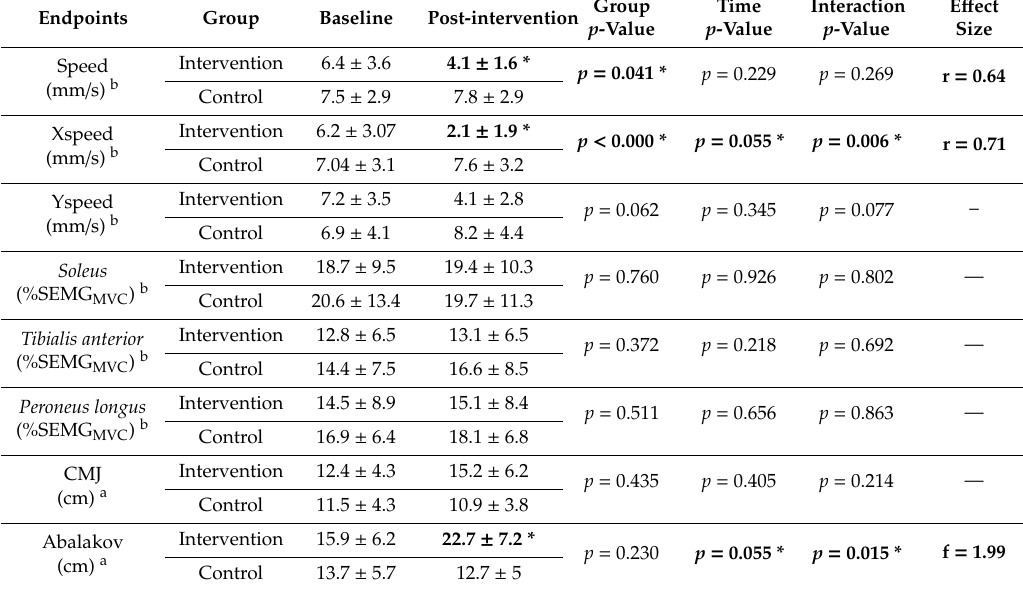
Table 3. E ff ects of the slackline program on the study’s